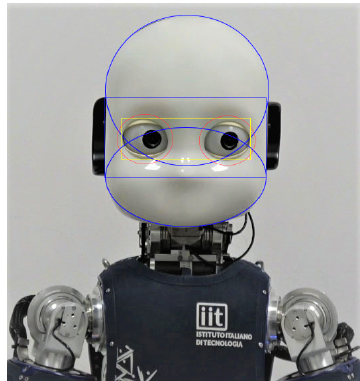
Figure 2: A frame of the trial sequence depicting the iCub robot. The figure indicates the Area of Interest (AoI) used for the analyses, de- fined as the yellow